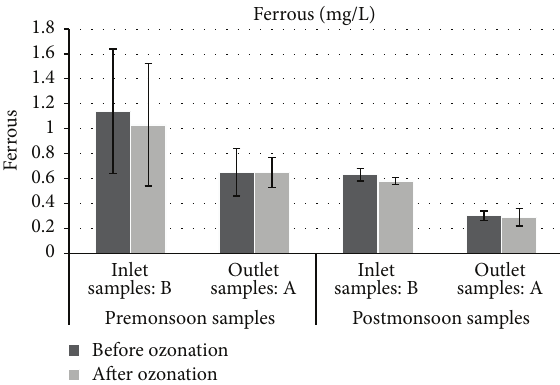
Figure 10: Ferrous concentration of inlet and outlet samples before and after treatment by